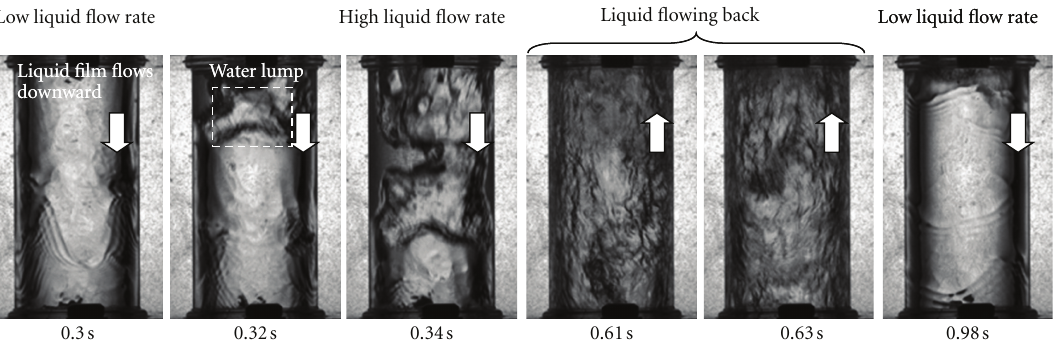
Figure 14: Flow patterns at the middle of the vertical pipe (Cylindrical tank (b), D = 30 mm, h = 450 mm, V Lower = 0 . 092 m 3 , and J G = 9 . 1